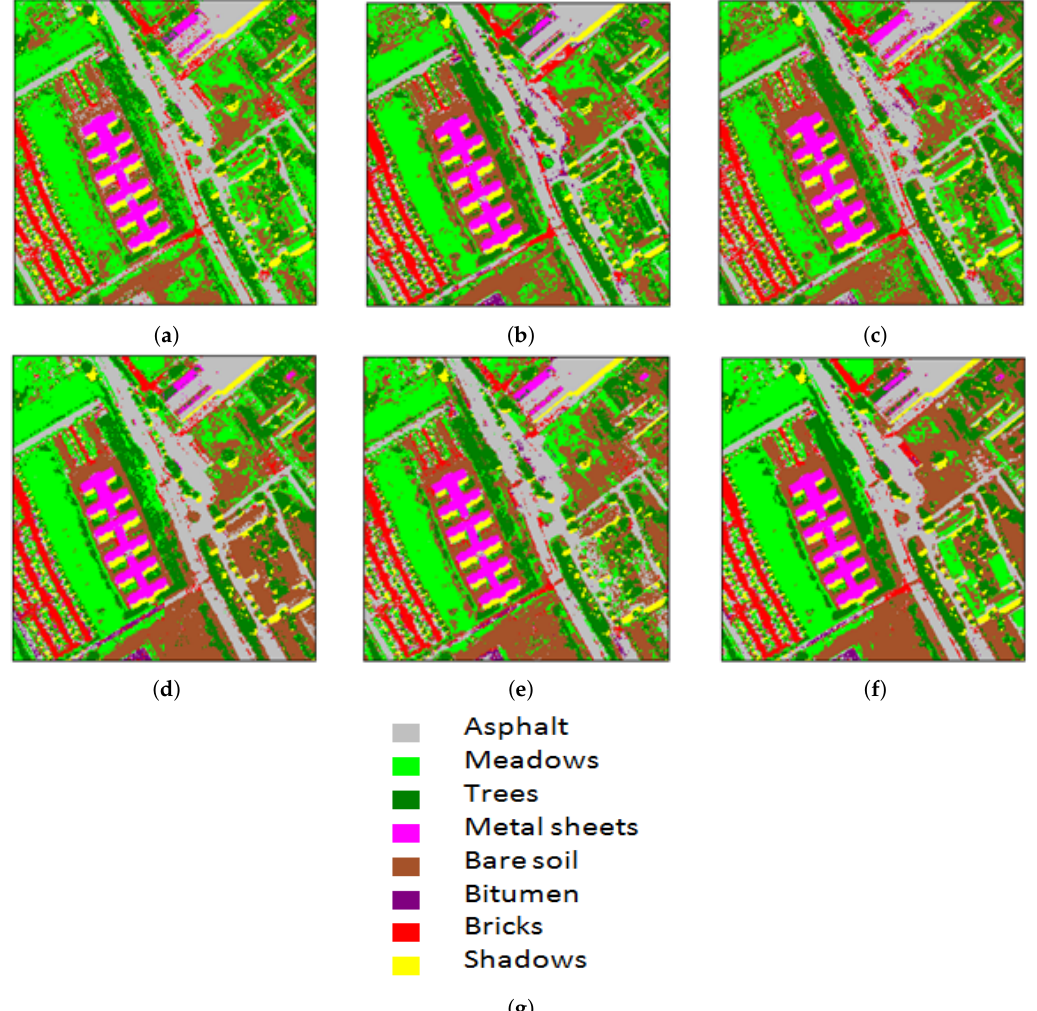
Figure 7. Classification map of different methods (256 × 256). ( a ) CNMF; ( b ) SC; ( c ) BS; ( d ) SUSC; ( e ) Hysure; ( f ) proposed method